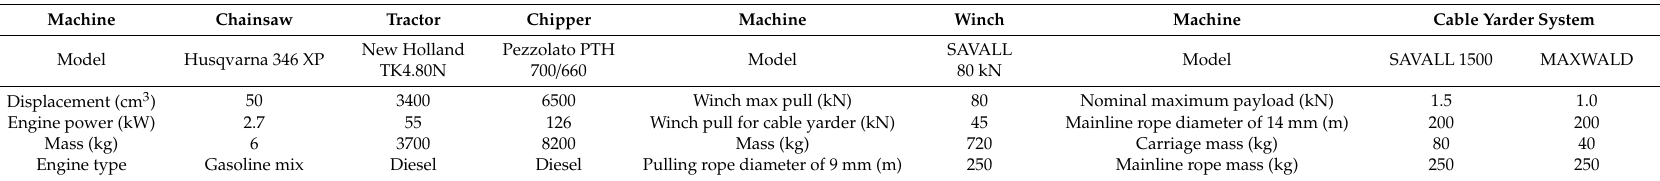
Table 2. Models and technical characteristics of the applied machines in the felling and extraction of marked trees from thinning